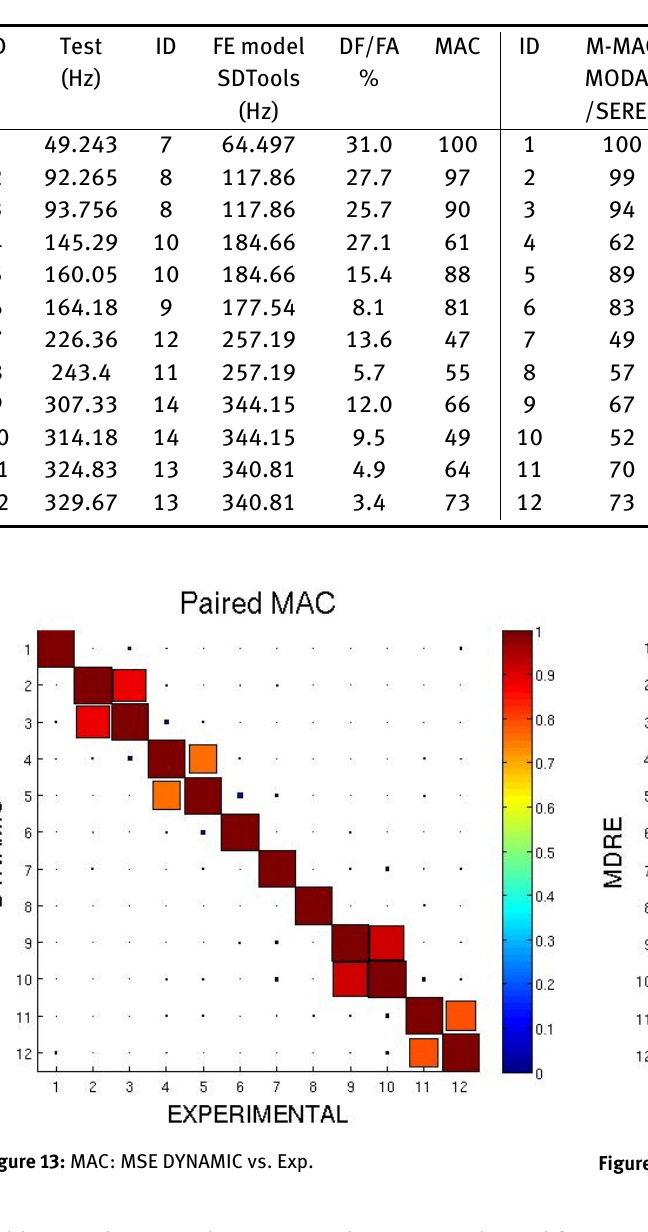
Table 8: Compartive MAC: Contrieved full model (SDTools) and M-MAC MSE results vs. experimental measurements.